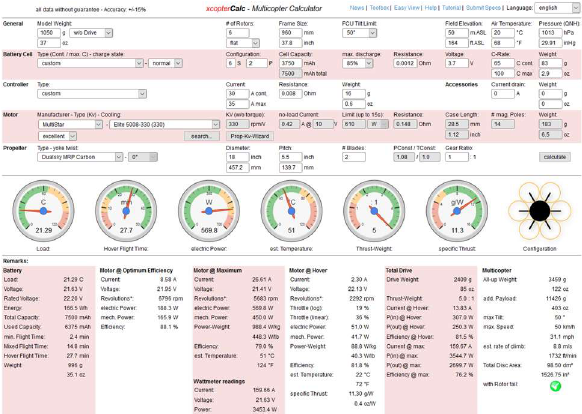
Figure 4. Simulation in xcopterCalc software.